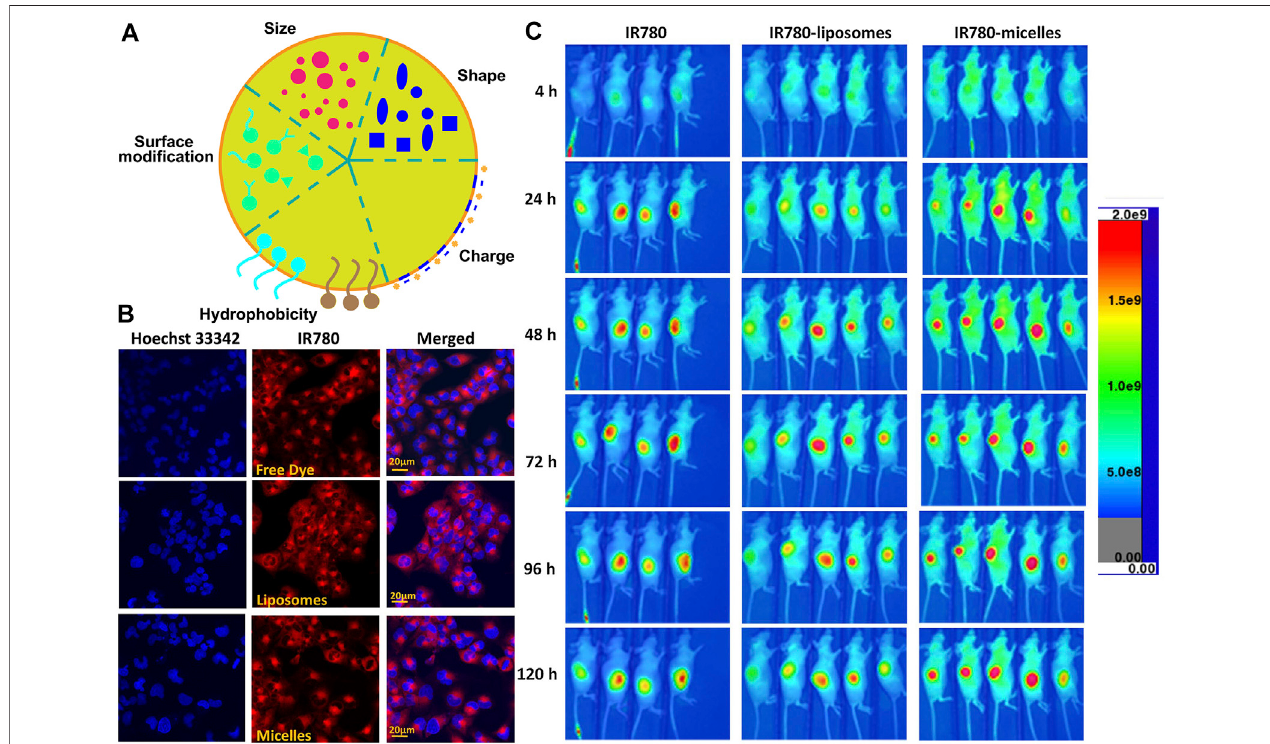
FIGURE6| CharacteristicsofCy7-basednanoparticles. (A) .Characteristicsofnanoparticles. (B) .T98G cellswerecultured withdifferentformulationsofIR780 for 30 min followed by Hoechst 33342 staining. Reproduced with permission from (Li S. et al., 2017). (C) In vivo NIRF imaging of IR780 nanoparticles with the U87M2/luc ectopic model. Reproduced with permission from (Li S. et al.,